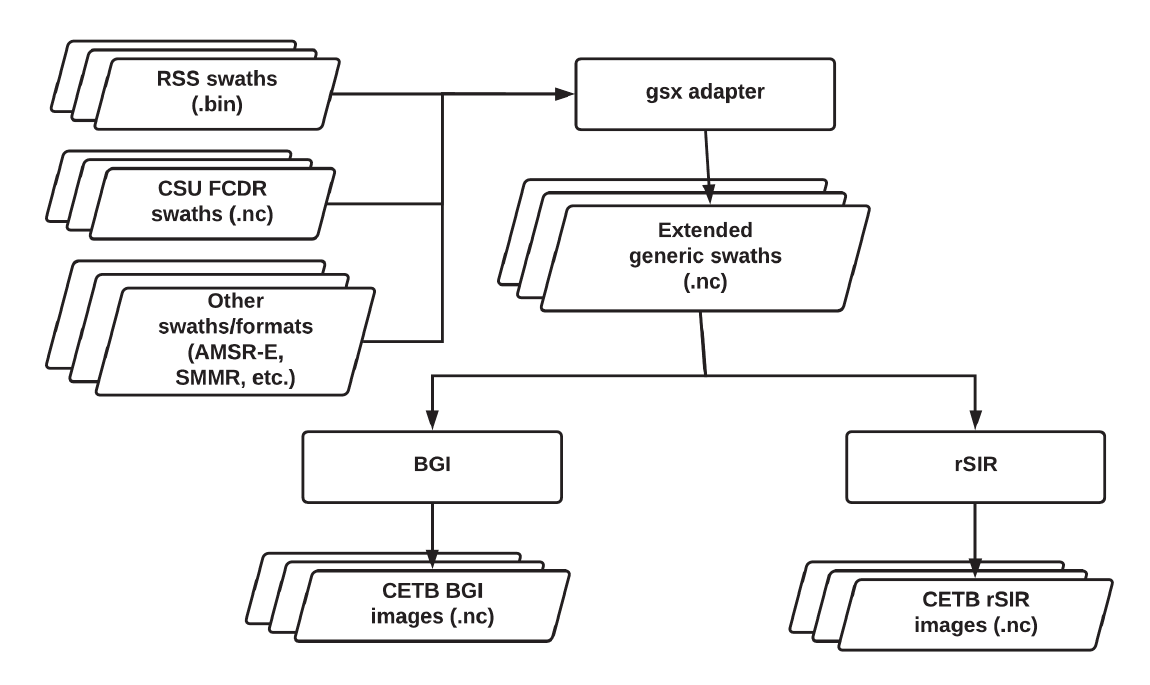
Figure 3. General design of modified CETB system, with the addition of a gsx adapter to handle multiple input sensors and formats, and the simplification of the BGI and rSIR